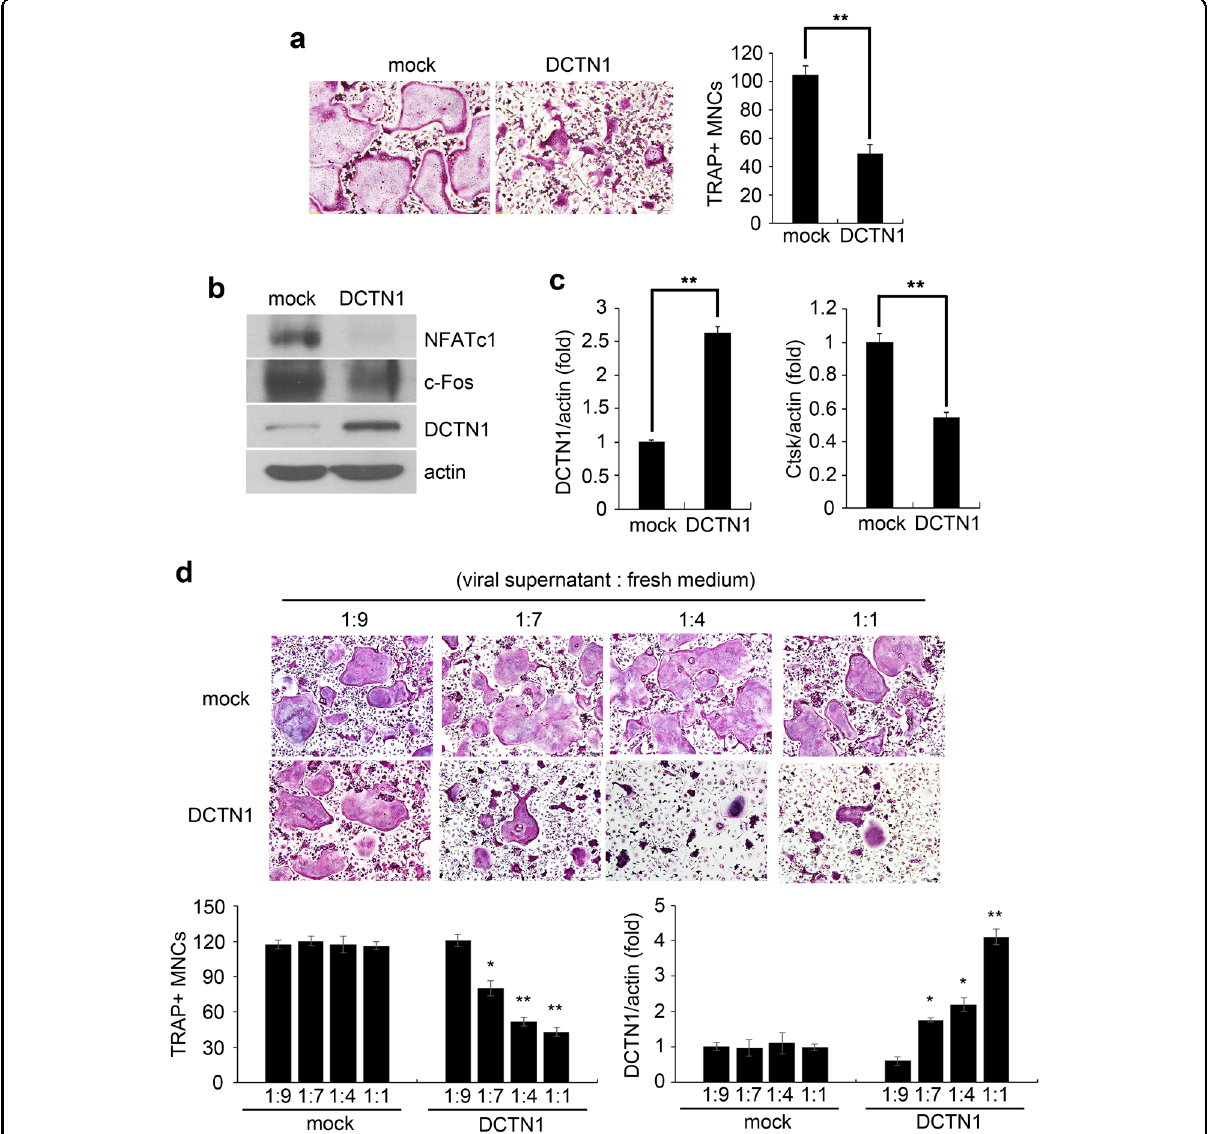
Fig. 7 Overexpression of DCTN1 interferes with OC differentiation. a BMMs infected with a retrovirus harboring DCTN1 or mock DNA were cultured in ODM for 4 days and stained for TRAP. TRAP-positive multinucleated cells were counted. b , c BMMs transduced as described in A were cultured in ODM for 48 h. NFATc1 and c-Fos protein levels were determined by western blotting. DCTN1 and Ctsk mRNA levels were analyzed by real- time PCR. d BMMs were infected with retroviral supernatant diluted at the indicated ratio (retroviral supernatant:fresh medium). Cells were further cultured in ODM for 4 days and stained for TRAP. TRAP-positive multinucleated cells were counted. DCTN1 mRNA levels were analyzed by real-time PCR. * p < 0.05, ** p < 0.005 compared with controls. Mock, pMX vector; DCTN1, pMX-DCTN1